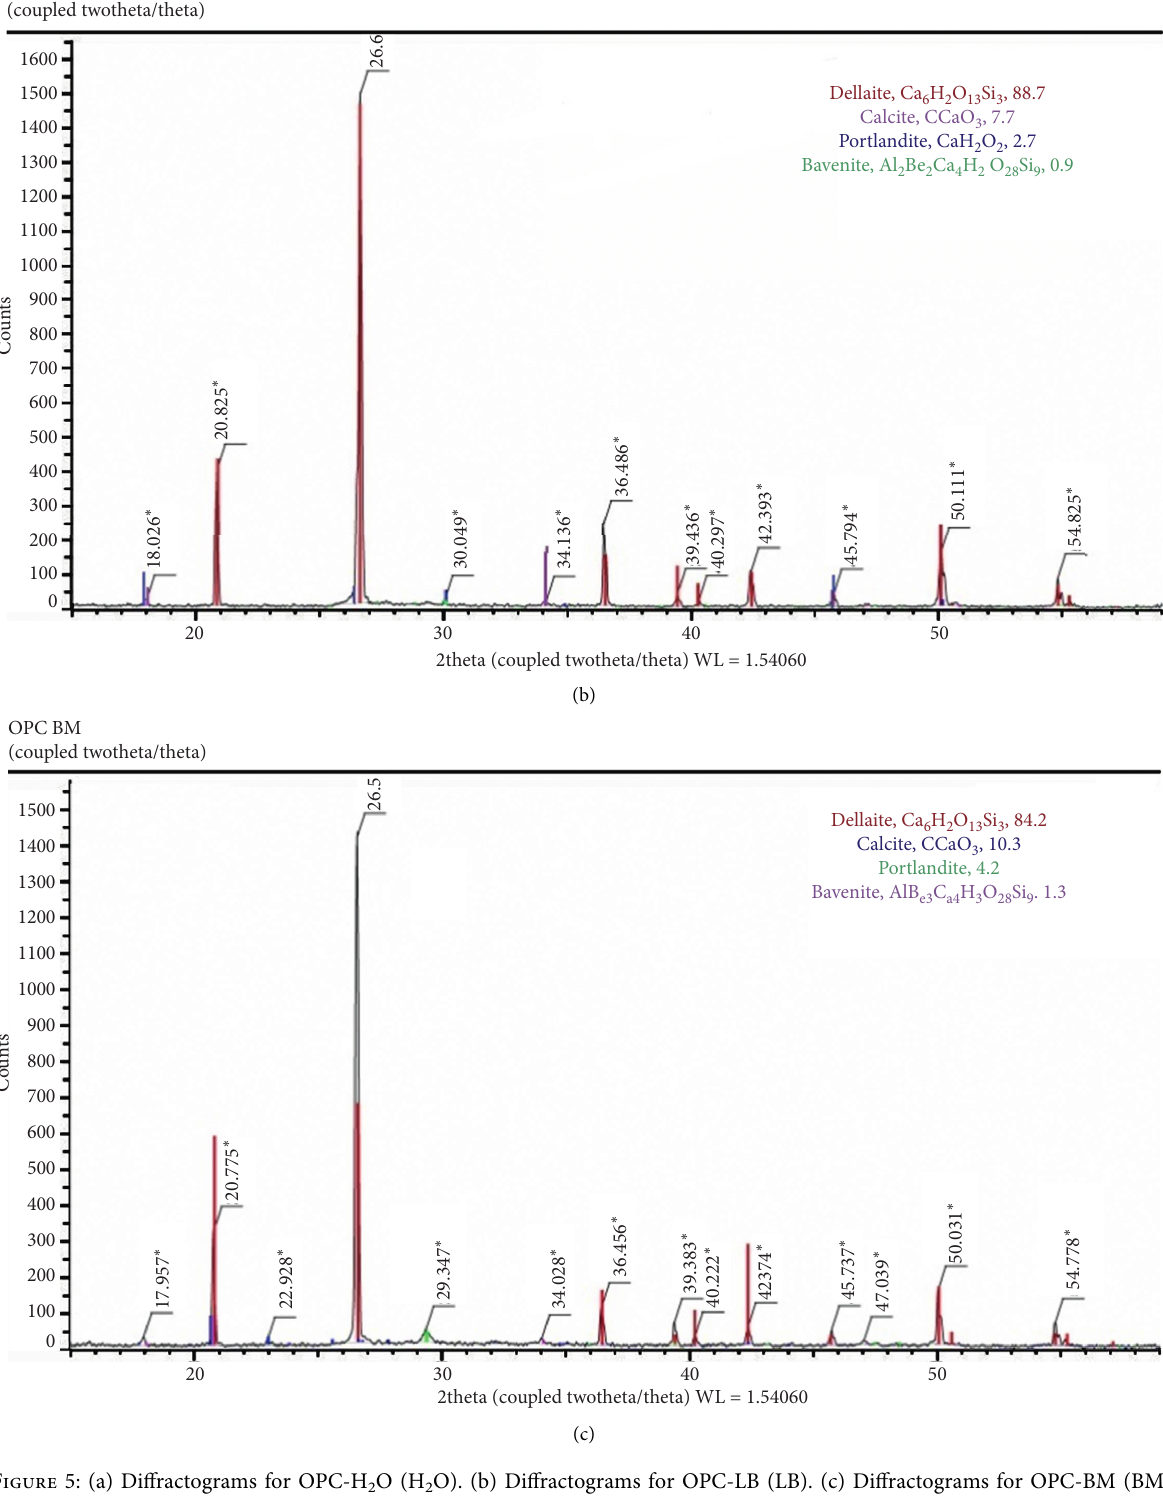
Figure 5: (a) Diffractograms for OPC-H 2 O (H 2 O). (b) Diffractograms for OPC-LB (LB). (c) Diffractograms for OPC-BM